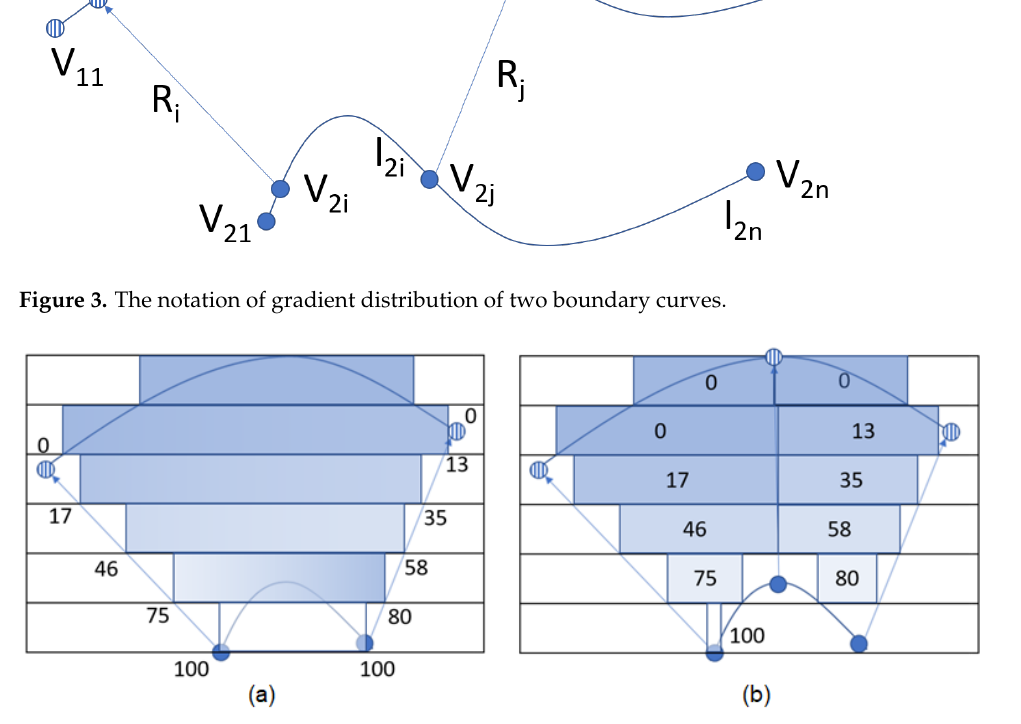
Figure 4. Planar slicing results between two curves with gradient distribution: ( a ) each slice and ( b ) each